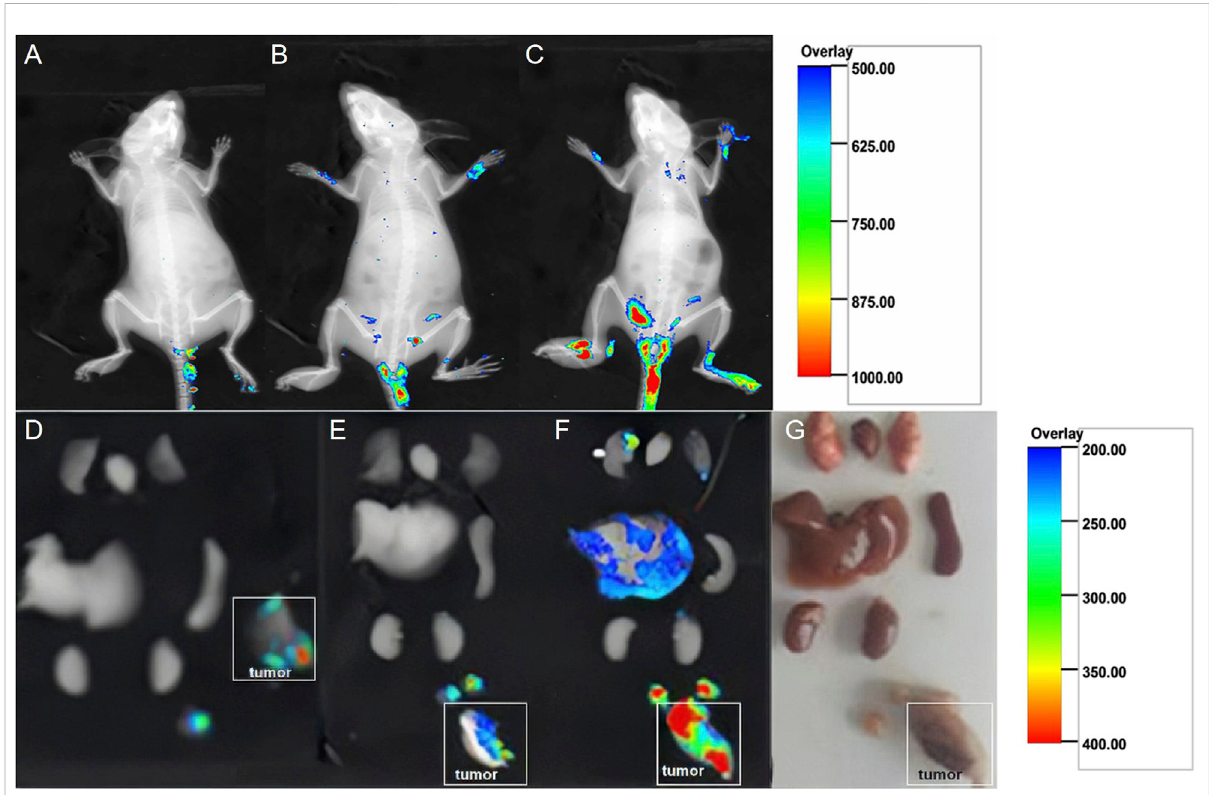
FIGURE 4 Fluorescenceimagesoflivingtumor-bearingmiceinjectedwiththesamedoseof fl uorescentNPs. (A) Controlgroup1:0.2 mlofDiI-labeledNS was injected. (B) Control group 2: 0.2 ml of DiI-labeled PLGA NPs was injected. (C) Experimental group: 0.2 ml of DiI-labeled GSN-PLGA NPs was injected. Fluorescence in the isolated organs, including the lungs, heart, liver, spleen, and kidneys, as well as implanted tumor tissues and